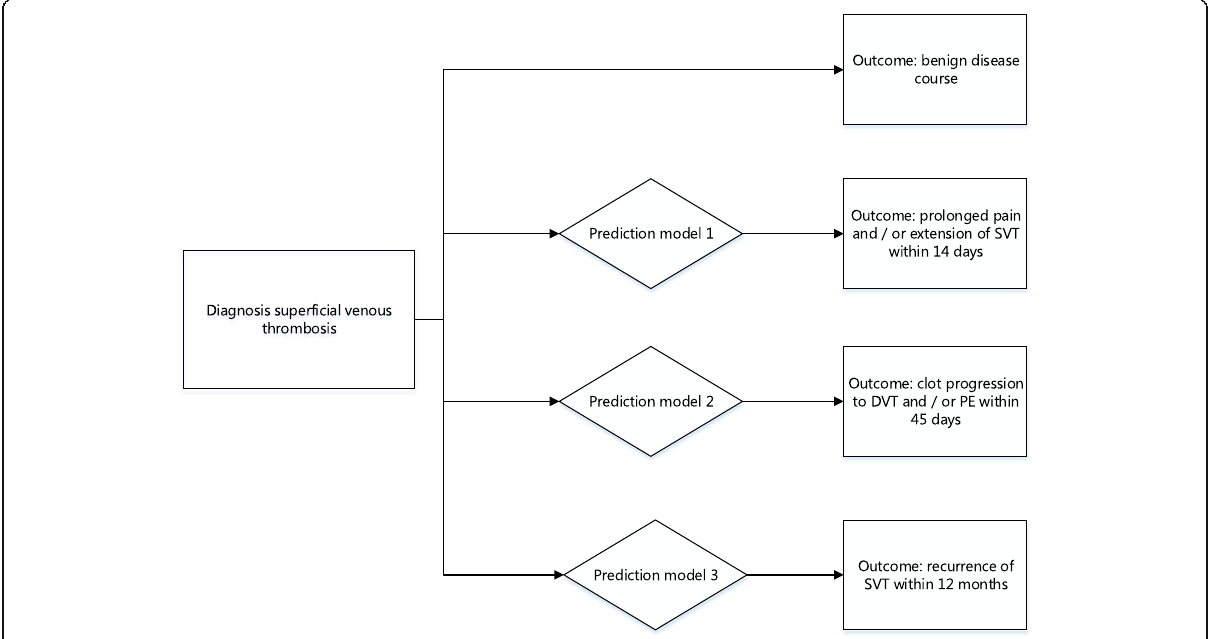
Fig. 1 Flow diagram of possible disease trajectories of superficial venous thrombosis